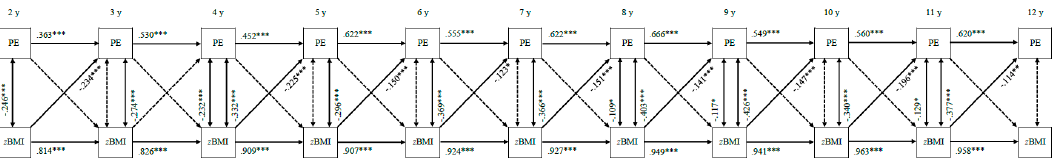
Figure 4. Bi-directional associations between pressure to eat and standardized child body mass index .